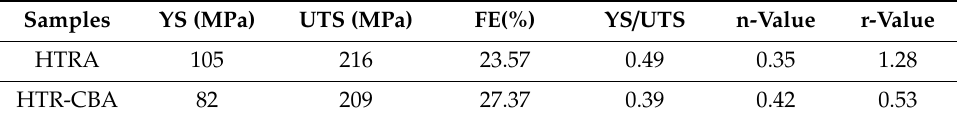
Figure 8. The stress-strain curves of the HTRA and HTR-CBA samples along the RD. Table 1. Mechanical properties of the HTRA and HTR-CBA samples along the